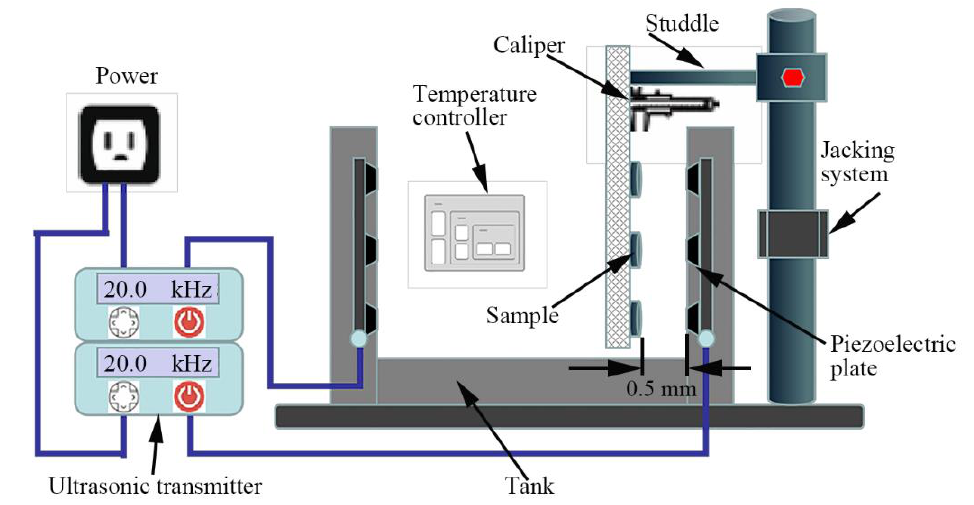
Figure 1. Schematic of the ultrasonic cavitation erosion device.